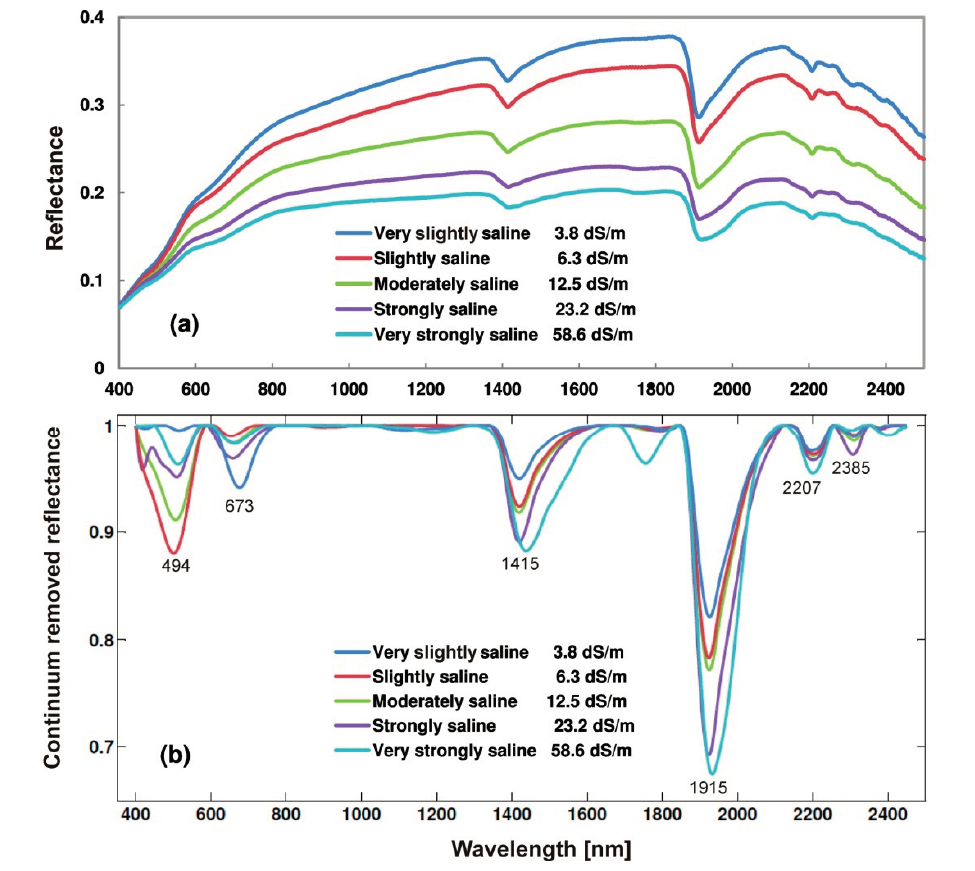
Figure 2. Raw reflectance spectra (R) ( a ); continuum-removed spectra (CR) ( b ) of five soil salinity